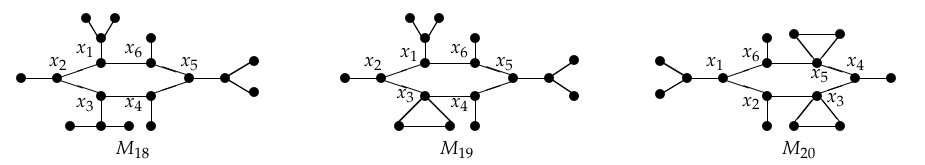
Figure 9. Three 4-cutwidth critical graphs with a C 6 .